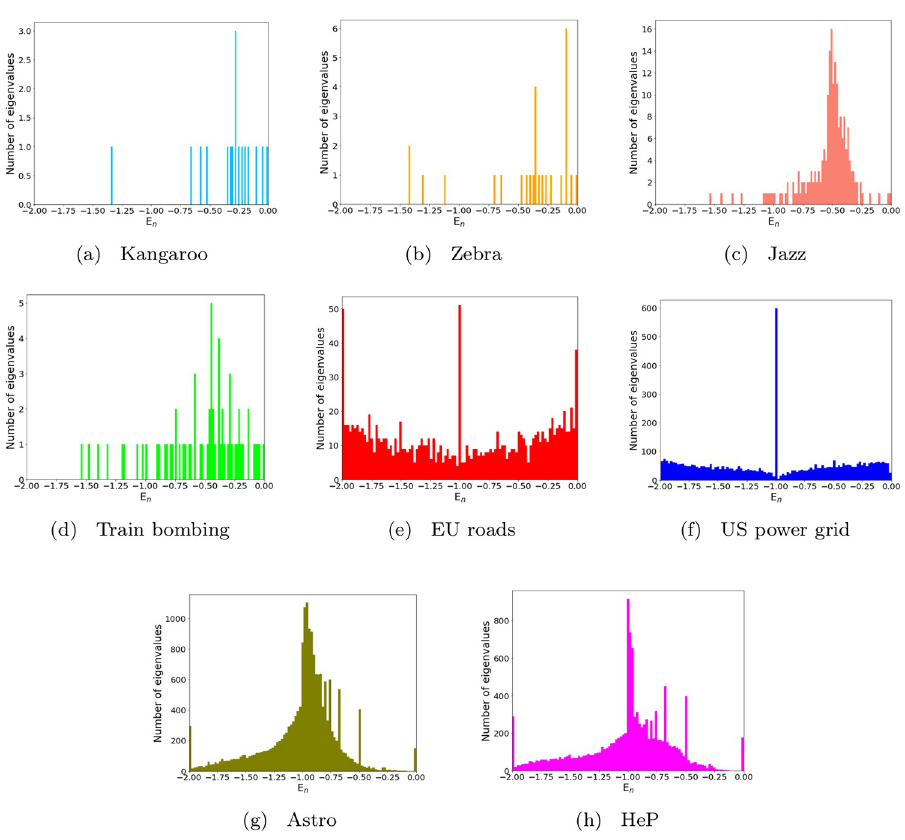
Fig 10. Real-world network spectral distributions. Distributions of graph eigenvalues, shifted to the interval [ − 2,0], related to the real-world networks reported in Table 1.